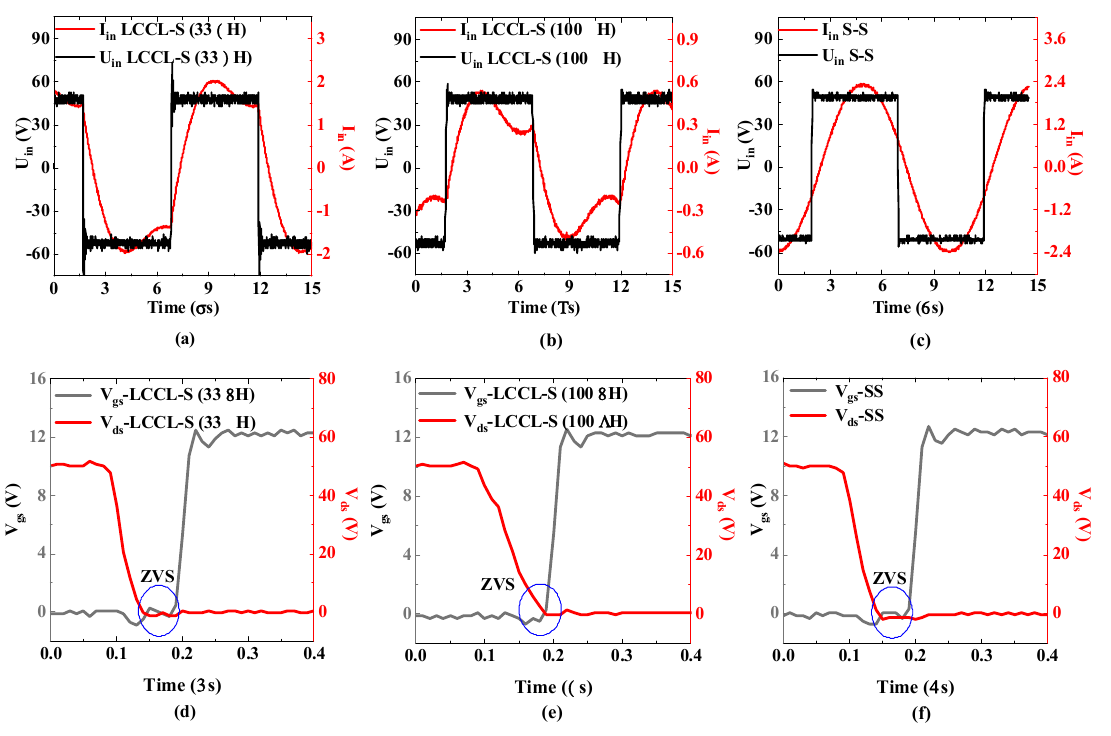
LCCL-S (33 μ H) is 121 V for a DC input voltage of 50 V, which is approximately 113 V in